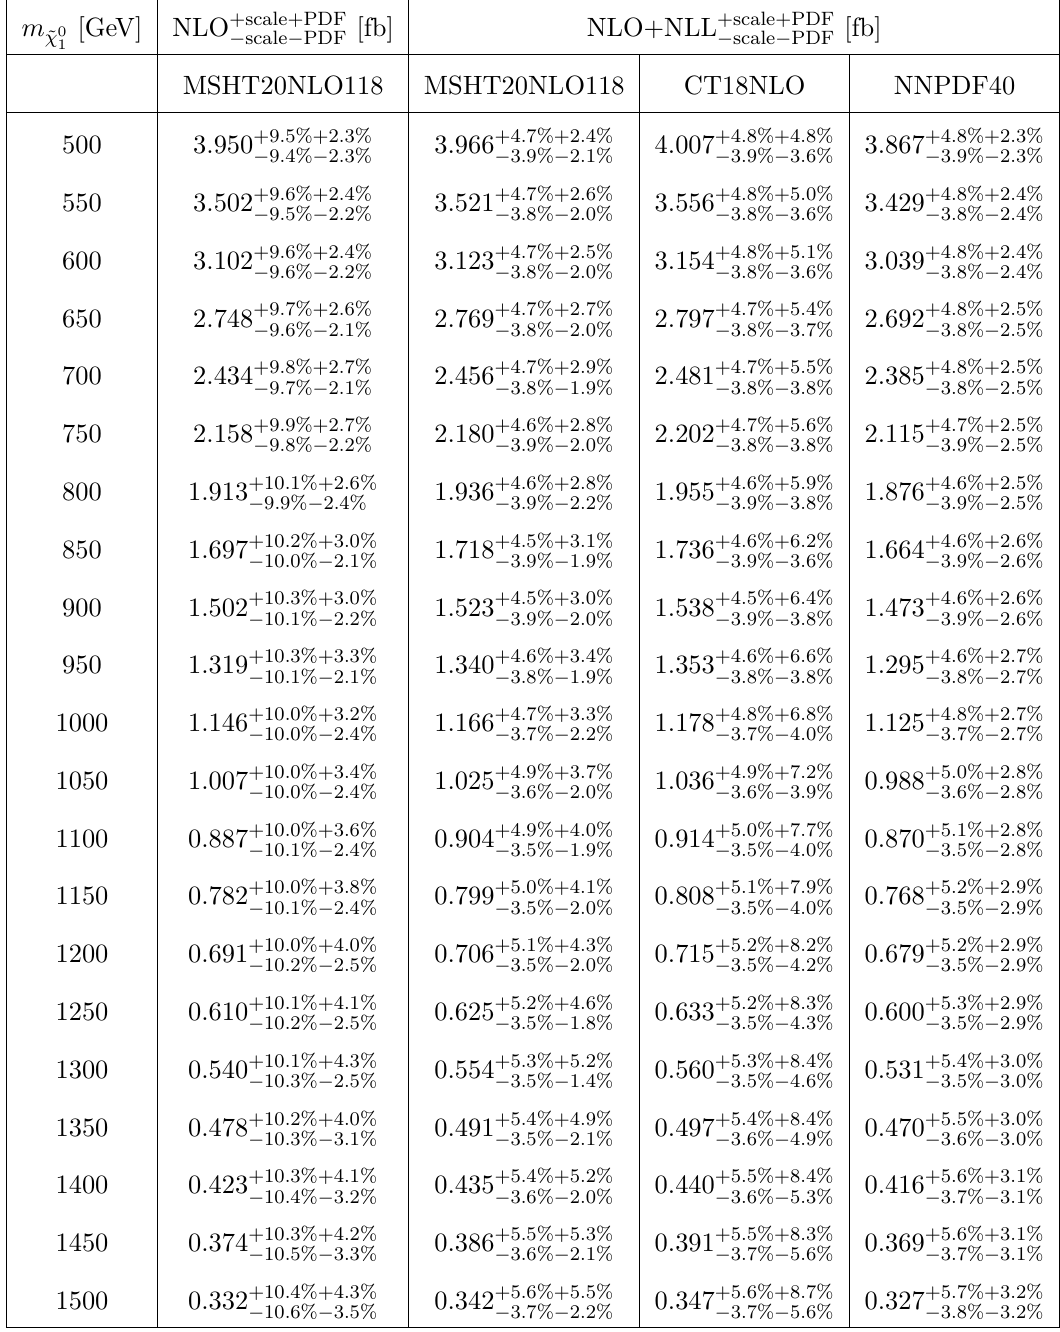
√ at S = 13 TeV at NLO and NLO+NLL for various 1